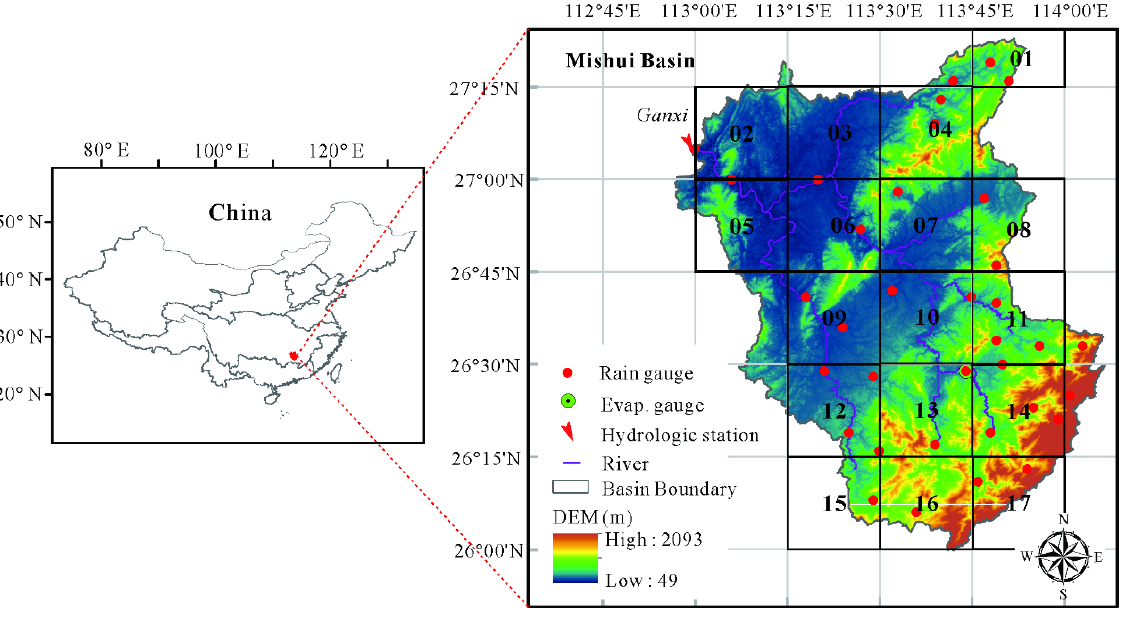
Figure 1. Digital elevation model (DEM) and spatial distribution of the rain gauge of the Mishui basin in south China.